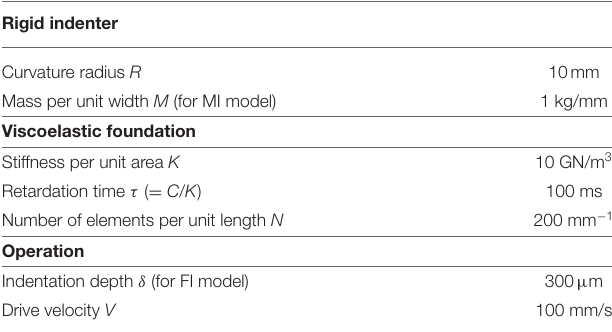
TABLE 1 | Standard parameter values for numerical